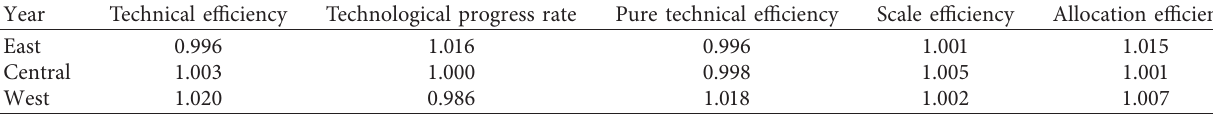
Table 2: Average allocation efficiency of financial R&D resources in each